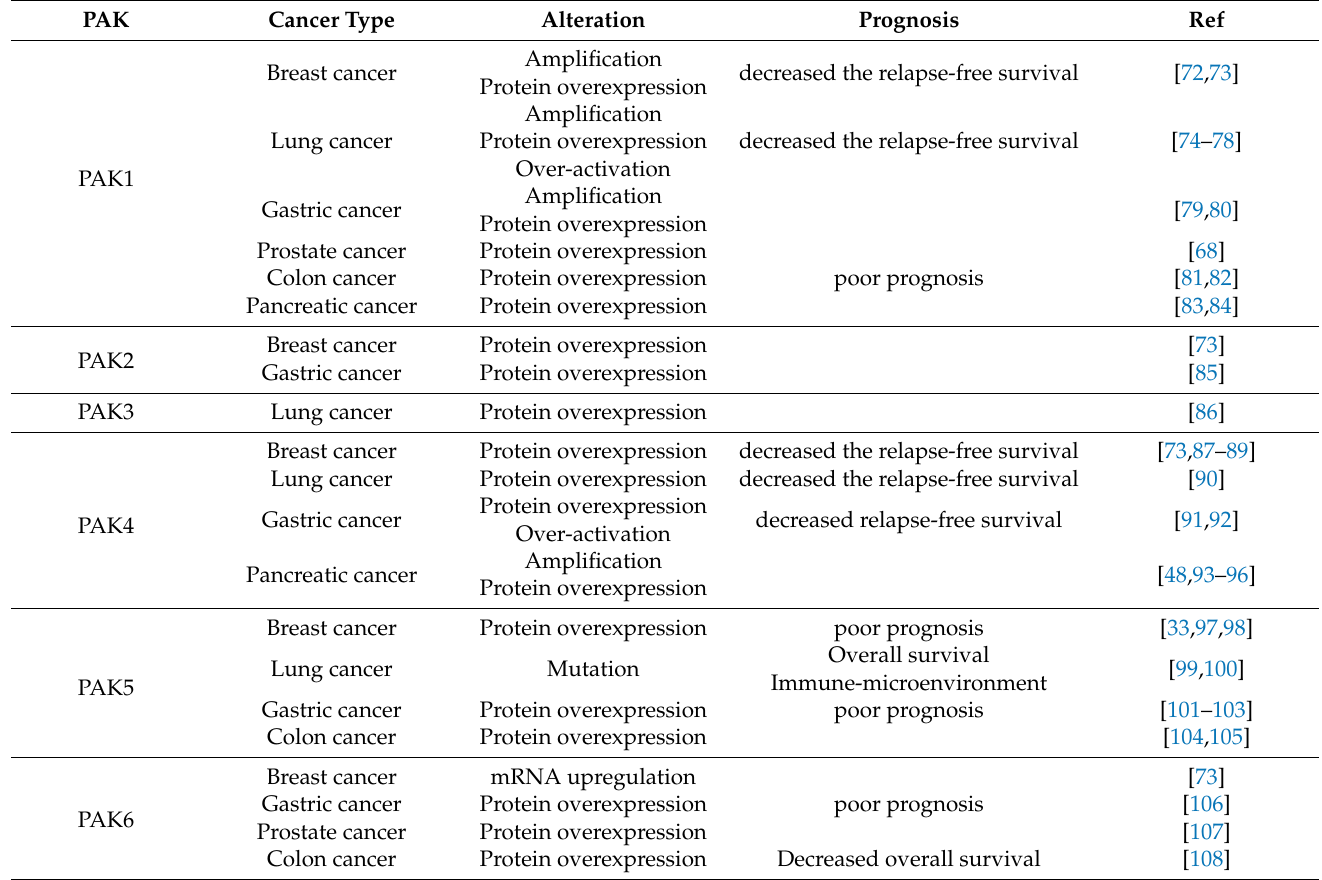
Table 2. PAK profile in human